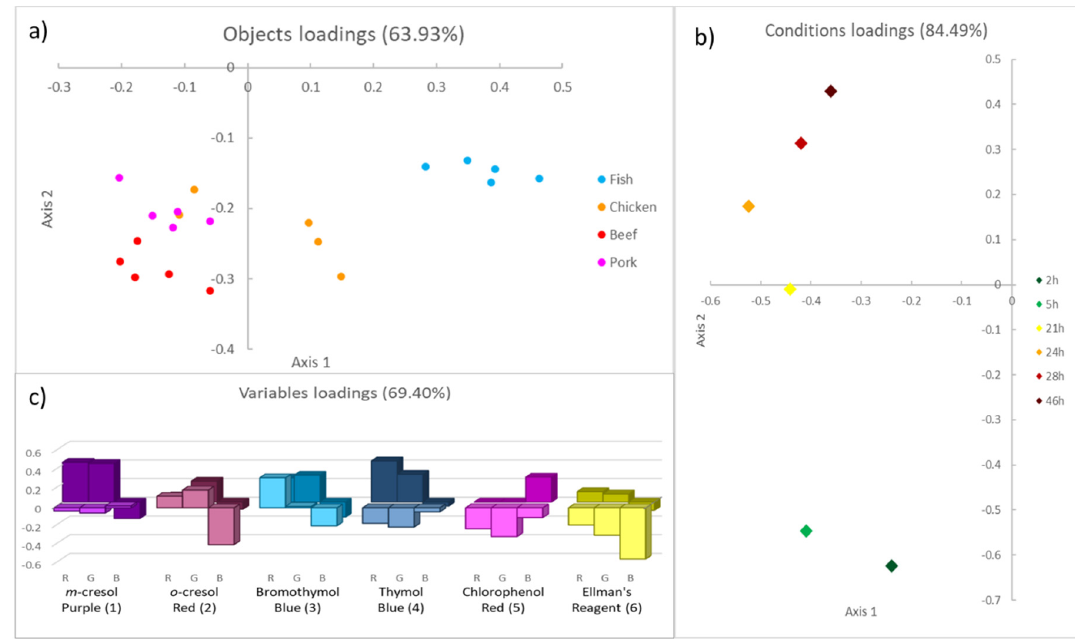
Figure 6. The loading plots of the three-way PCA model on the first two axes: objects loading plots ( a ), conditions loading plots ( b ) and variables loading plots ( c ).